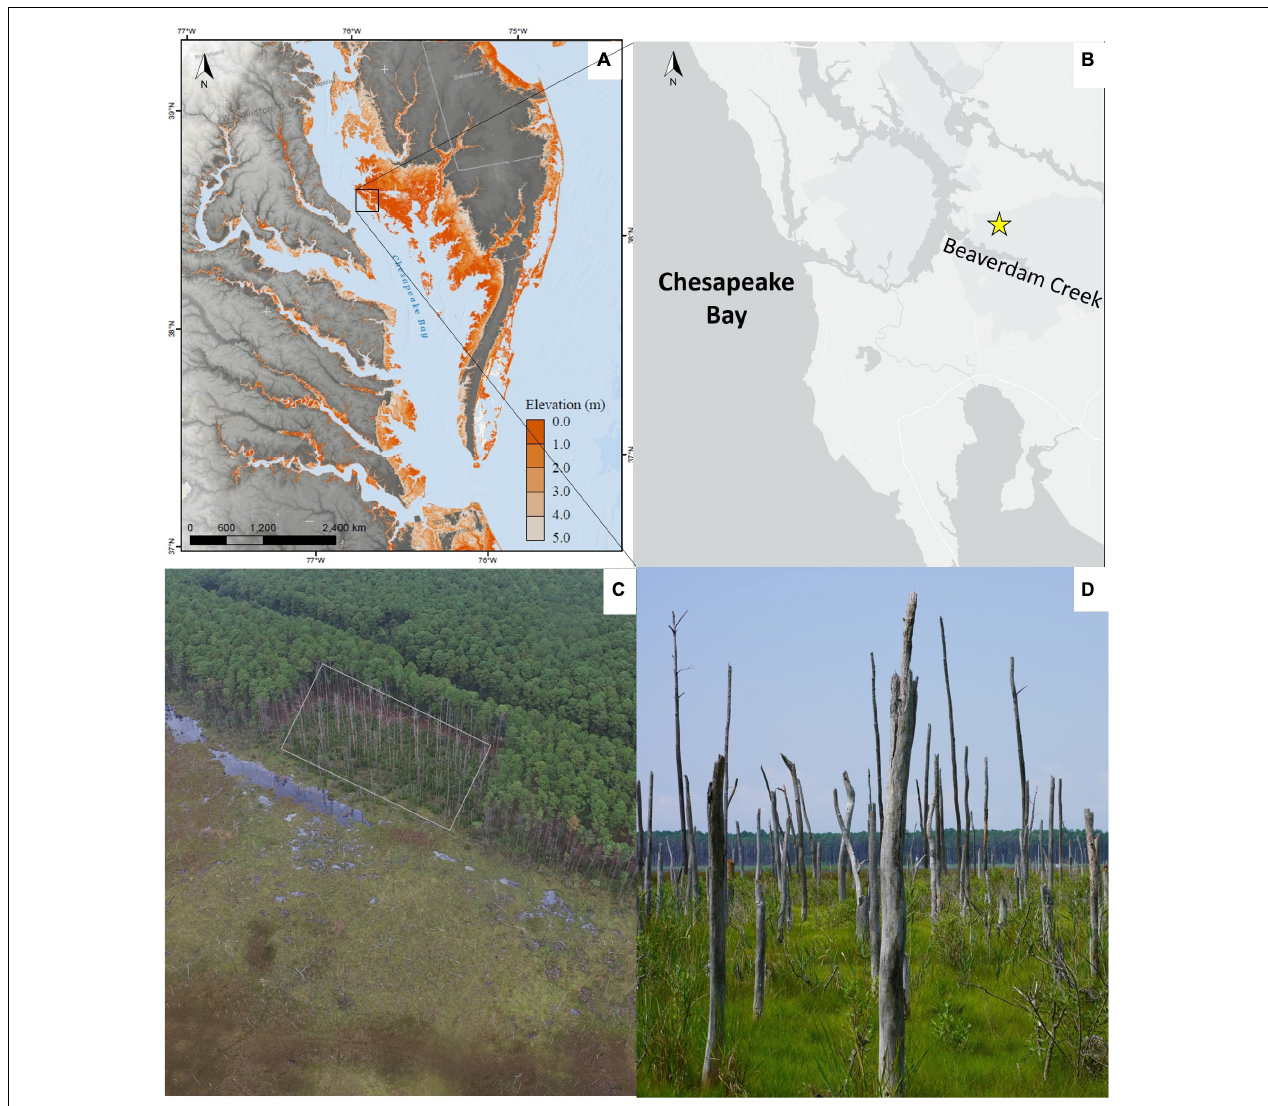
FIGURE 1 | (A) Map of Chesapeake Bay region with an overlaid topobathymetric digital elevation model that displays elevation of areas < 5.0 m NAVD88, from the United States Geological Survey’s Coastal National Elevation Database (Danielson and Tyler, 2016). Inset black box shows the position of the transgression experiment at the Blackwater National Wildlife Refuge on Maryland’s Eastern Shore of the Chesapeake Bay. (B) Site map showing Moneystump Swamp (yellow star) at the Blackwater National Wildlife Refuge situated on Beaverdam Creek, a tributary of the Chesapeake Bay, where the transgression experiment took place. (C) Aerial image of the Moneystump transgression experiment taken in 2018. The Control area is on the right side of the image where there are live trees, showing the natural gradient of pine forest transitioning to emergent brackish marsh. The overlayed rectangle shows the area where trees were killed via girdling (Credit: Tyler Messerschmidt). (D) Picture taken from within the ghost forest in the high marsh at Moneystump, looking parallel to the marsh forest boundary with the live forest to the right and the marsh extending out to the left. These trees are a sign of natural transgression that has occurred at this site (Credit: David C.